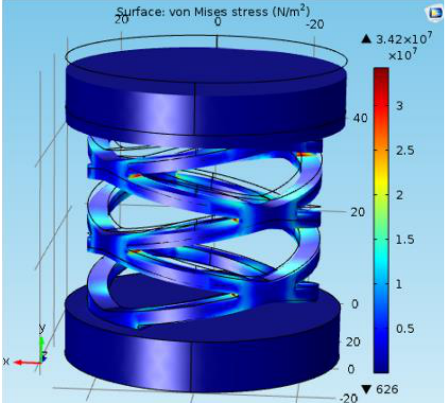
Figure 5. Structural simulation of arch spring